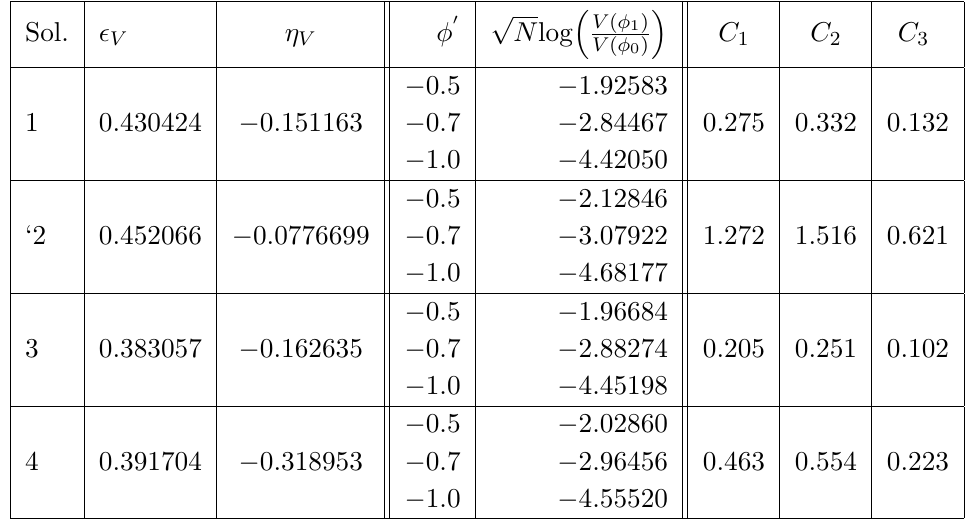
Table 2 . Values of (cid:15) V , (cid:17) V and presented in the tables of appendix A of